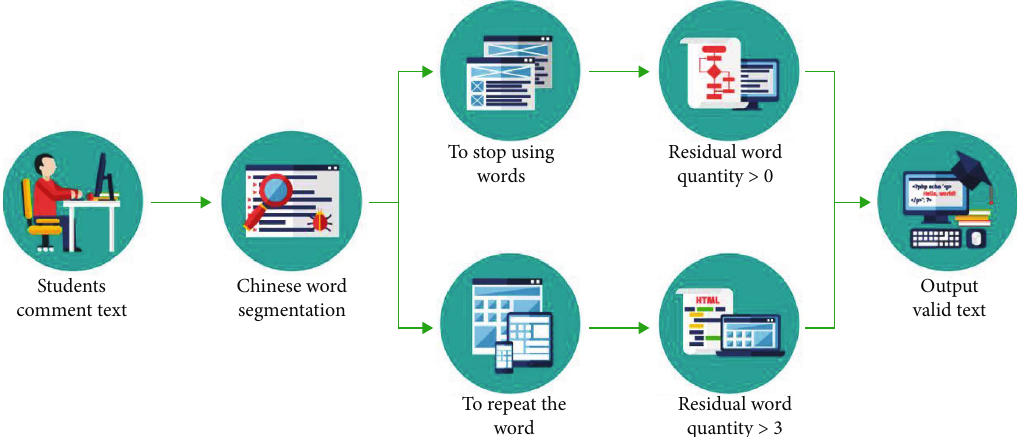
Figure 1: Review teaching text cleaning process. Table 3: Initial teaching evaluation